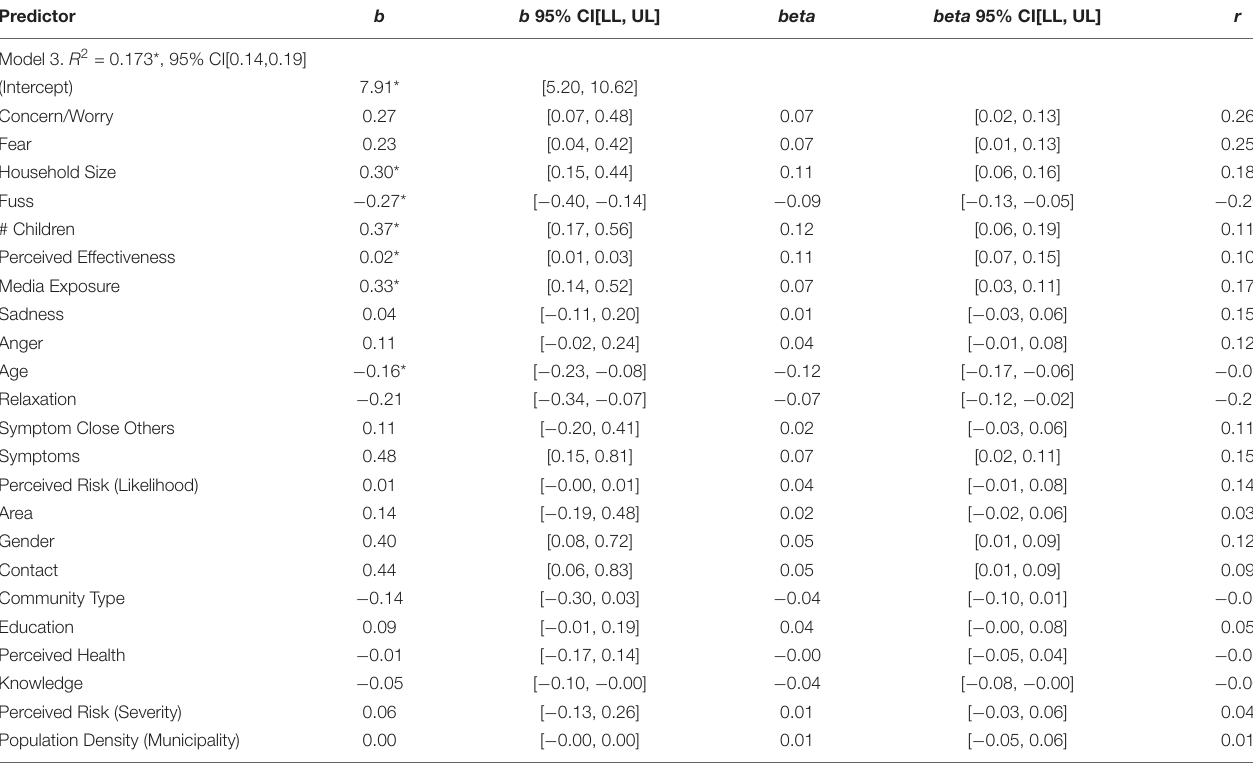
TABLE 2 | Regression results using health-protective behavior as the criterion. Predictor b b 95% CI[LL, UL]